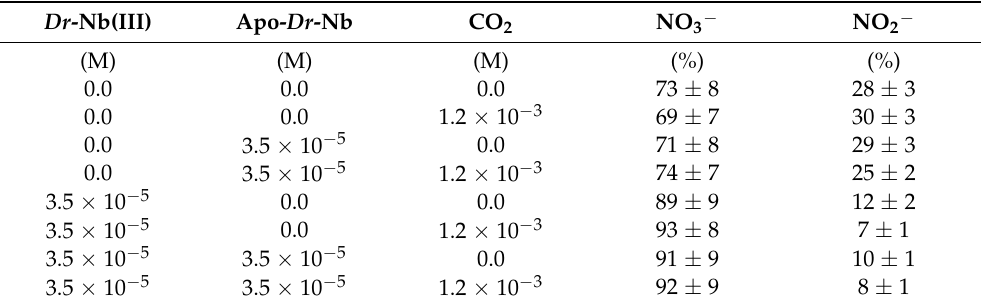
a The peroxynitrite concentration was 2.0 × 10 − 4 M; 5.0 × 10 − 2 M Bis-Tris propane